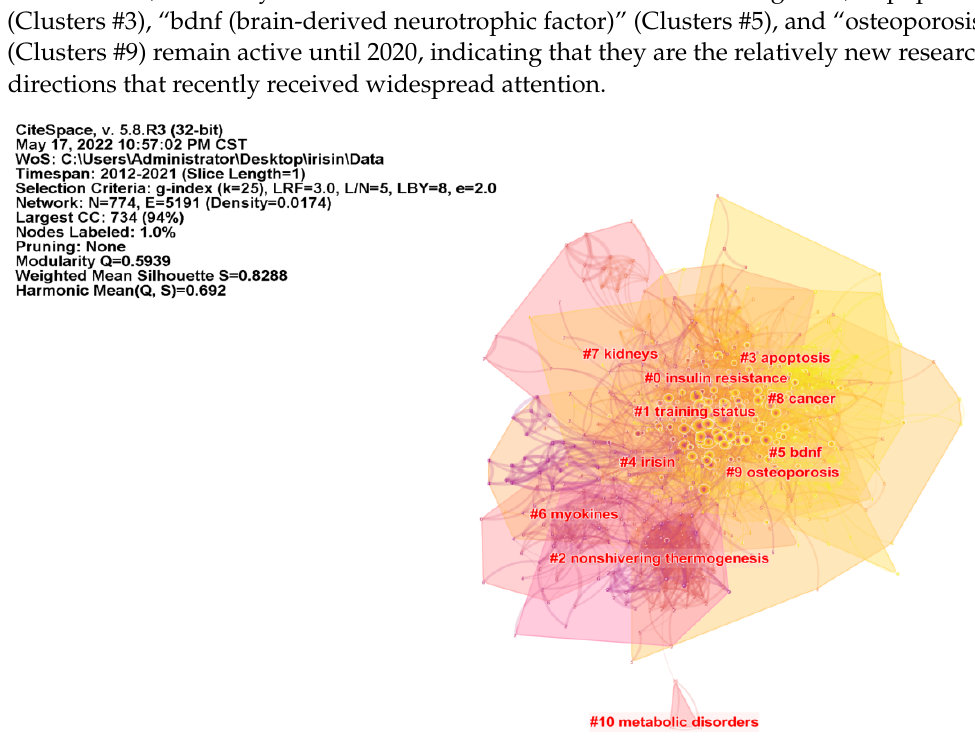
Figure 7. Clusters of reference co-citation network in irisin research. Each node in the figure equals a cited reference, and the larger the node, the higher the citation frequency. In addition, each node in the RCA network can be clustered together according to its inter-connectivity, and each cluster represents a different professional or subject concept.